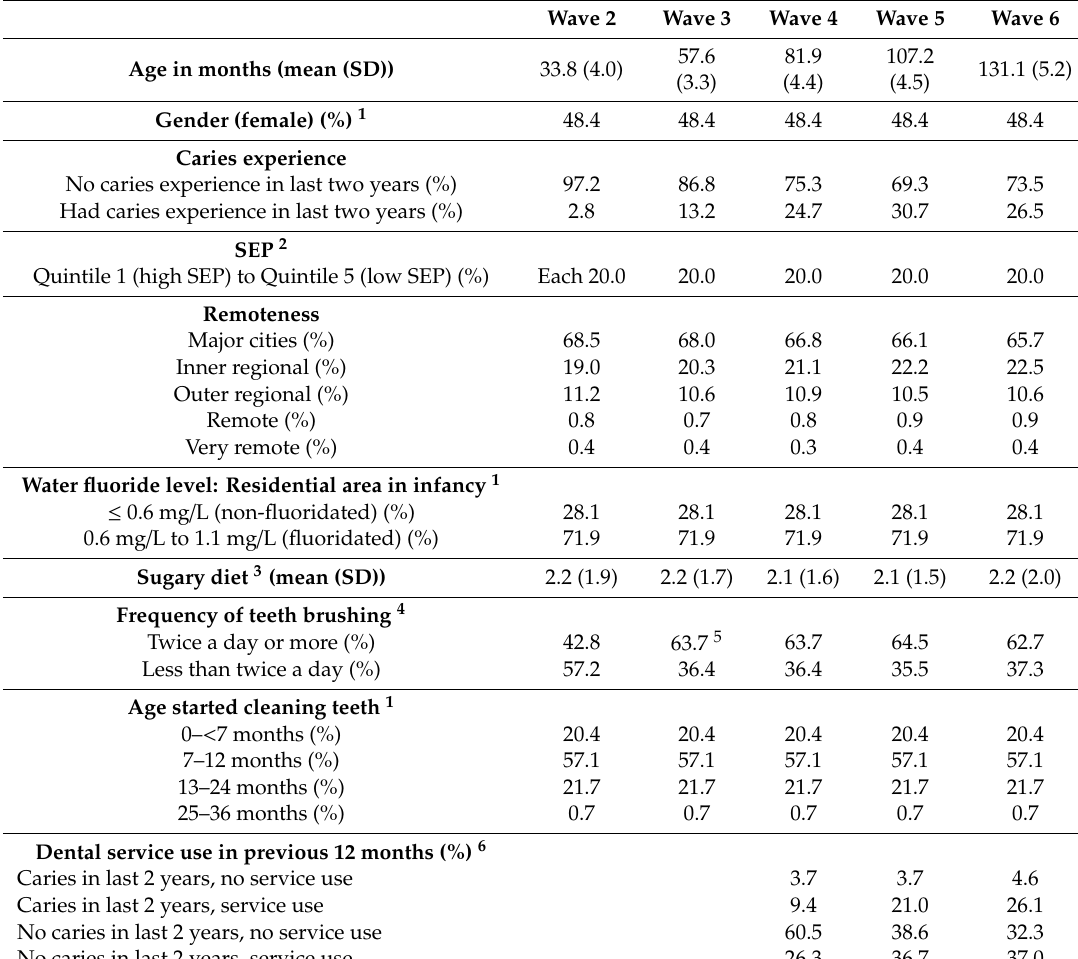
Table 1. Characteristics of children and parent-reported oral health data (weighted to representative Australian